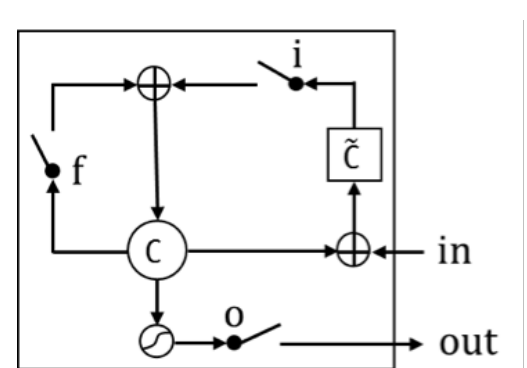
Figure 2. An example of the LSTM